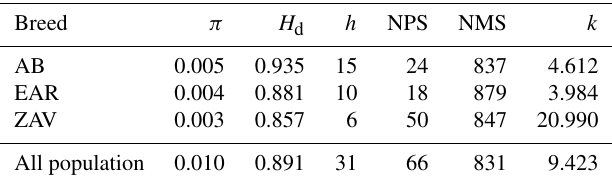
Table 1. An overview of genetic diversity parameters in studied breeds.